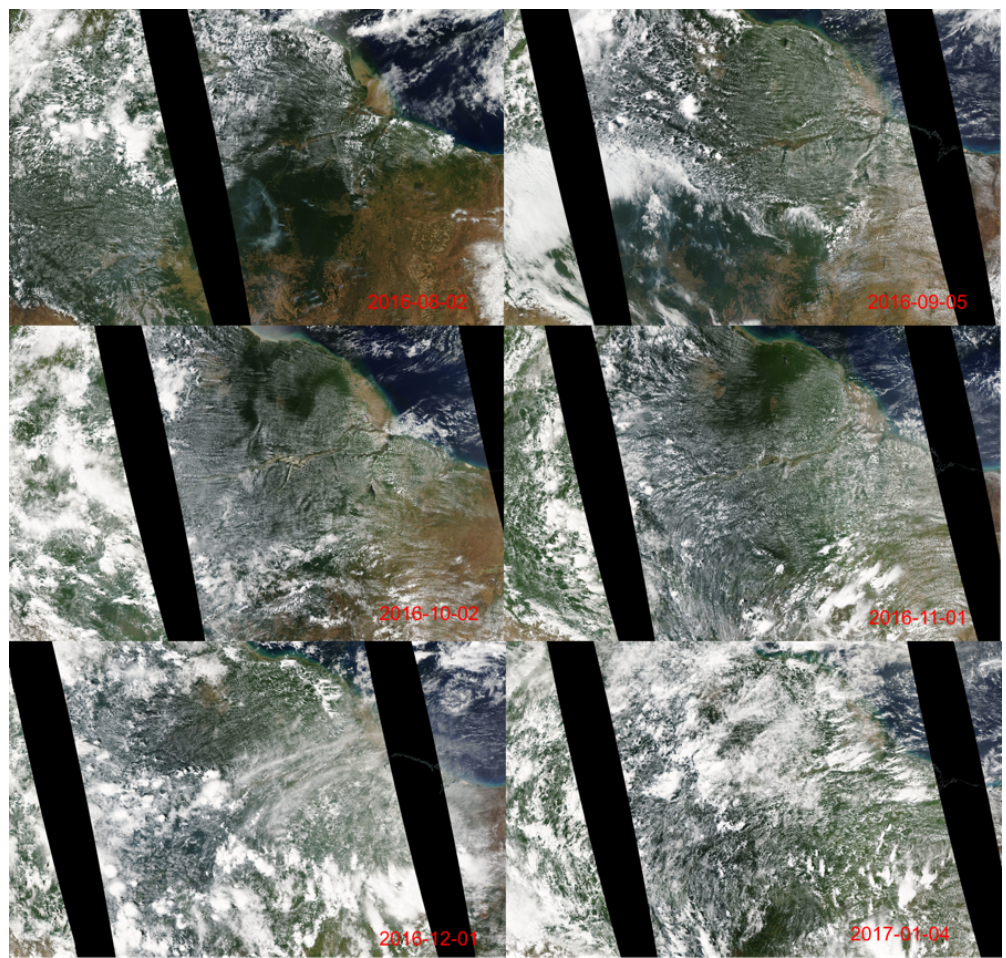
Figure 15. MODIS visible image of the northwestern Amazon as the basin transitions into the wet season. In the dry season, surface heterogeneity, whether due to rivers, forest-deforested patches, or land–ocean contrast, is very clear. In the wet season those sharp gradients disappear as cloud cover mostly dominated by deep convection starts organizing at scales independent of the surface